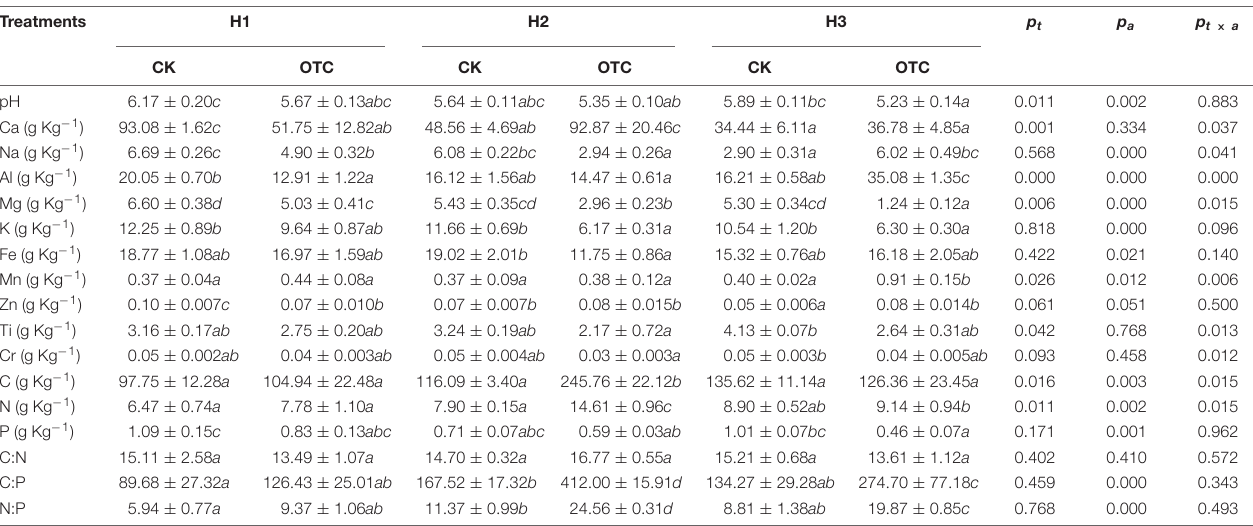
TABLE 2 | Soil element contents (g Kg − 1 ) in the ambient and open top chambers (OTC). Treatments